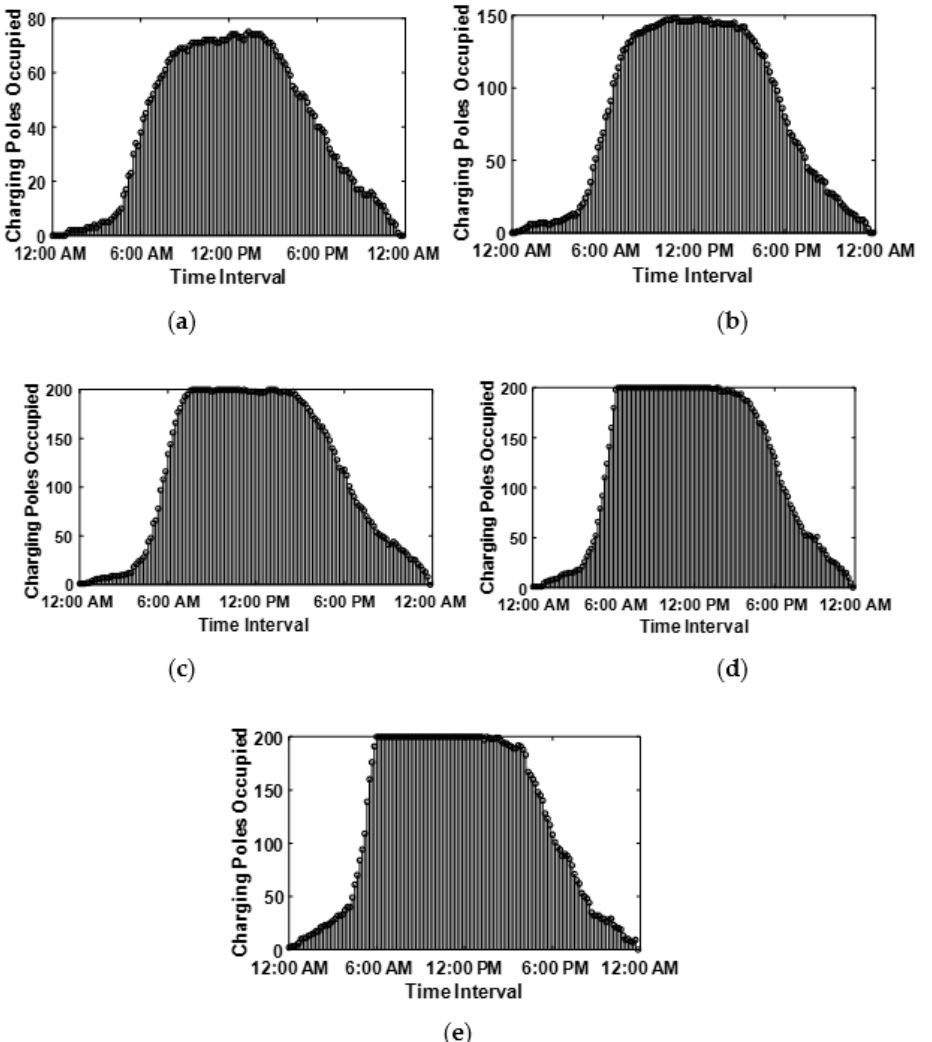
Figure 2. Number of Charging Pole Captured when ( a ) E = 100, ( b ) E = 200, ( c ) E = 300, ( d ) E = 400, and ( e ) E =